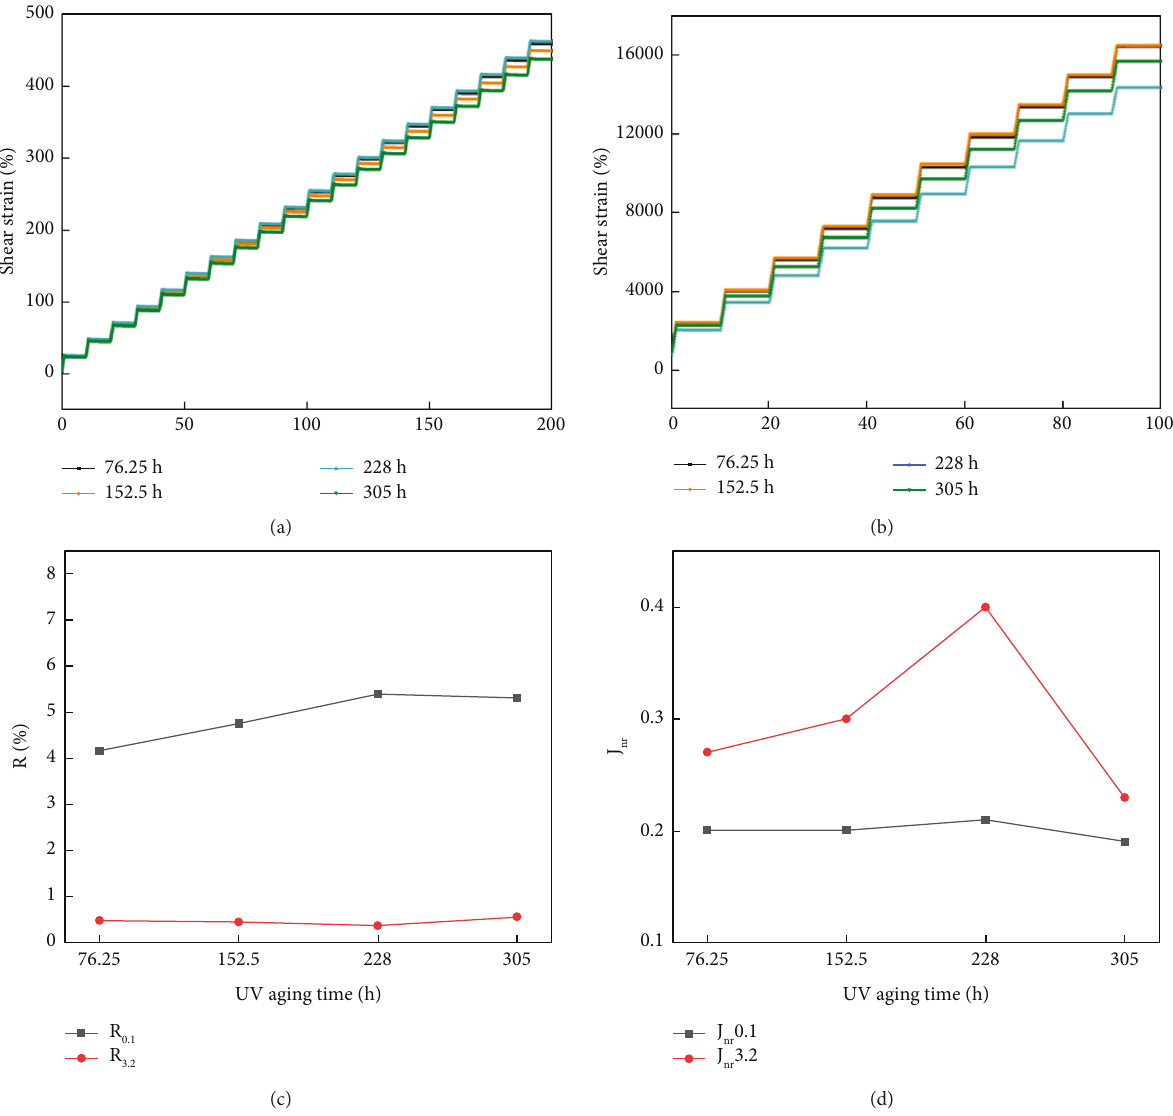
Figure 6: MSCR testing results of ASA-modified asphalt subjected to UV radiation of different times. (a) 0.1 kPa. (b) 3.2 kPa. (c) R value. (d) Jnr